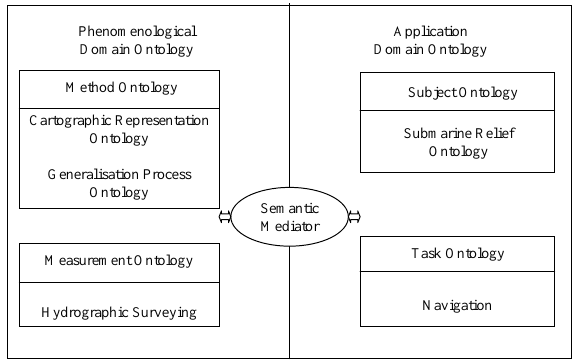
Figure 3: Structure of the ontology